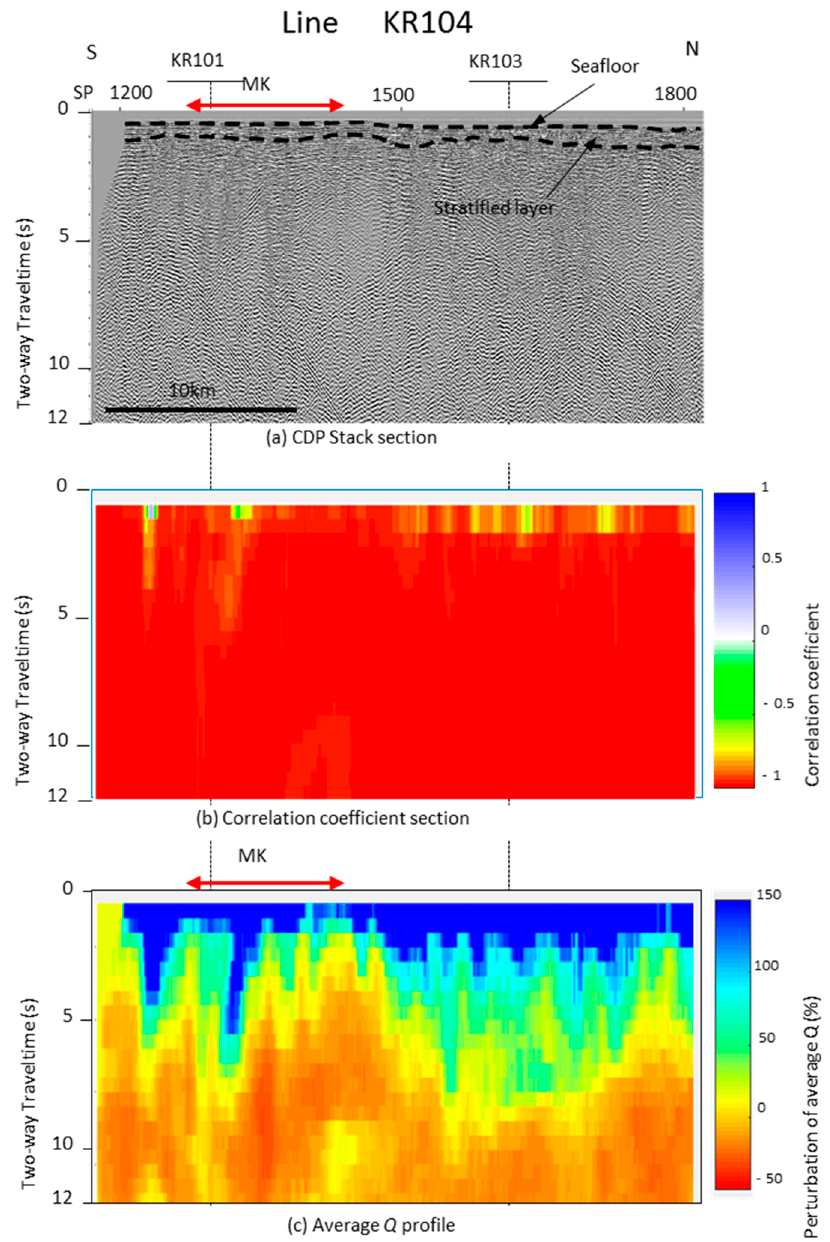
Figure 9. CDP stack section ( a ), correlation coefficient section ( b ), and average Q profile ( c ) of line KR104. The stratified layer with continuous reflections was imaged in the shallowest part on the CDP stack section; however, no reflections can be observed below the layer. The correlation coefficient section shows that almost all of the correlation coefficients in the linear approximation of gradient p represent highly negative correlations (less than − 0.8). An up-warping high attenuation anomaly can be observed on the average Q profile near the Miyakejima volcano (see Figure 1).